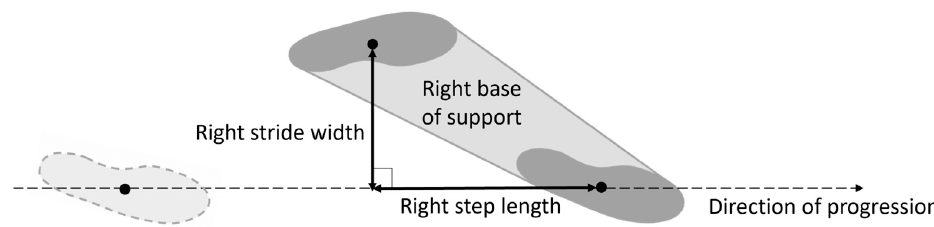
Figure 1. Gait parameters related to a right base of support, with reference to a right gait cycle. The position of a footprint is approximated by its centroid. The direction of progression for the right gait cycle is identified by the line connecting the centroids of two consecutive right footprints.